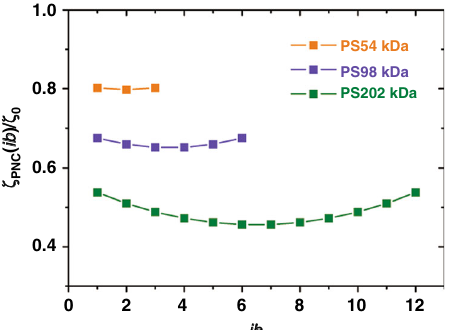
Fig. 9 Friction coef fi cient ratios, ζ PNC ð ib Þ = ζ 0 , plotted as a function of the index of entanglement blobs ( ib ) along the chain with the de fi nition in Eq. (3) and the fi tting parameters of ϕδ ¼ 0 : 0792 and α ¼ 0 : 0759 from ð Z Þ and ζ Fig. 8. ζ are friction coef fi cient on blobs in the composite and PNC 0 pure PS melt